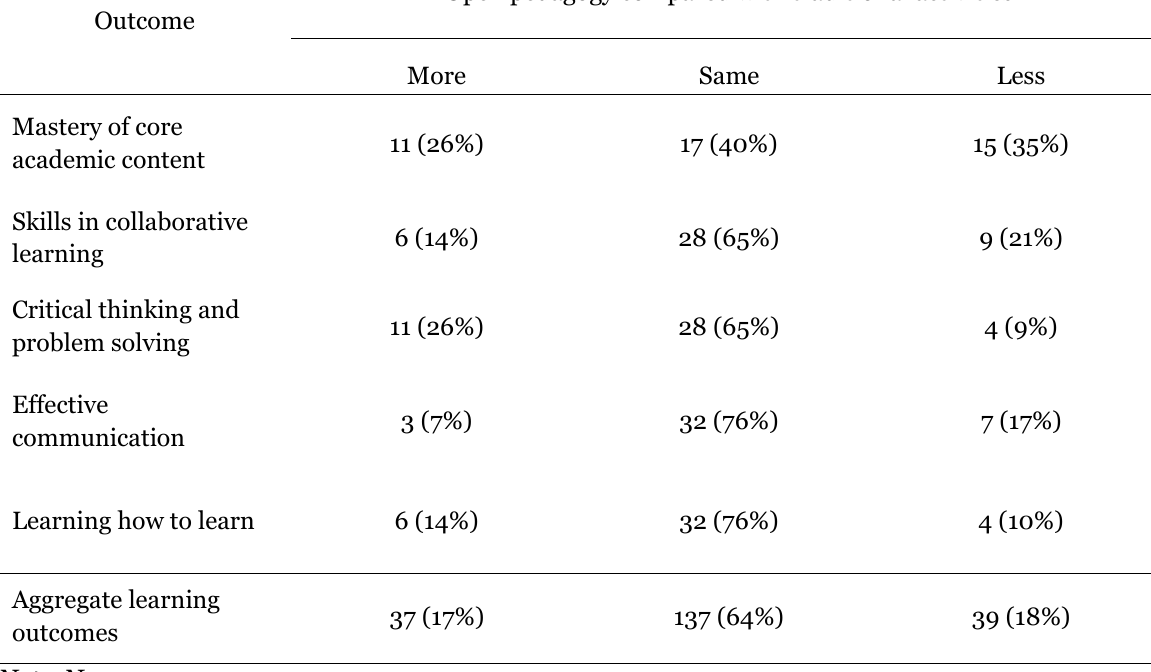
Student Perceptions of Open Pedagogy With Multiple-Choice Question Creation